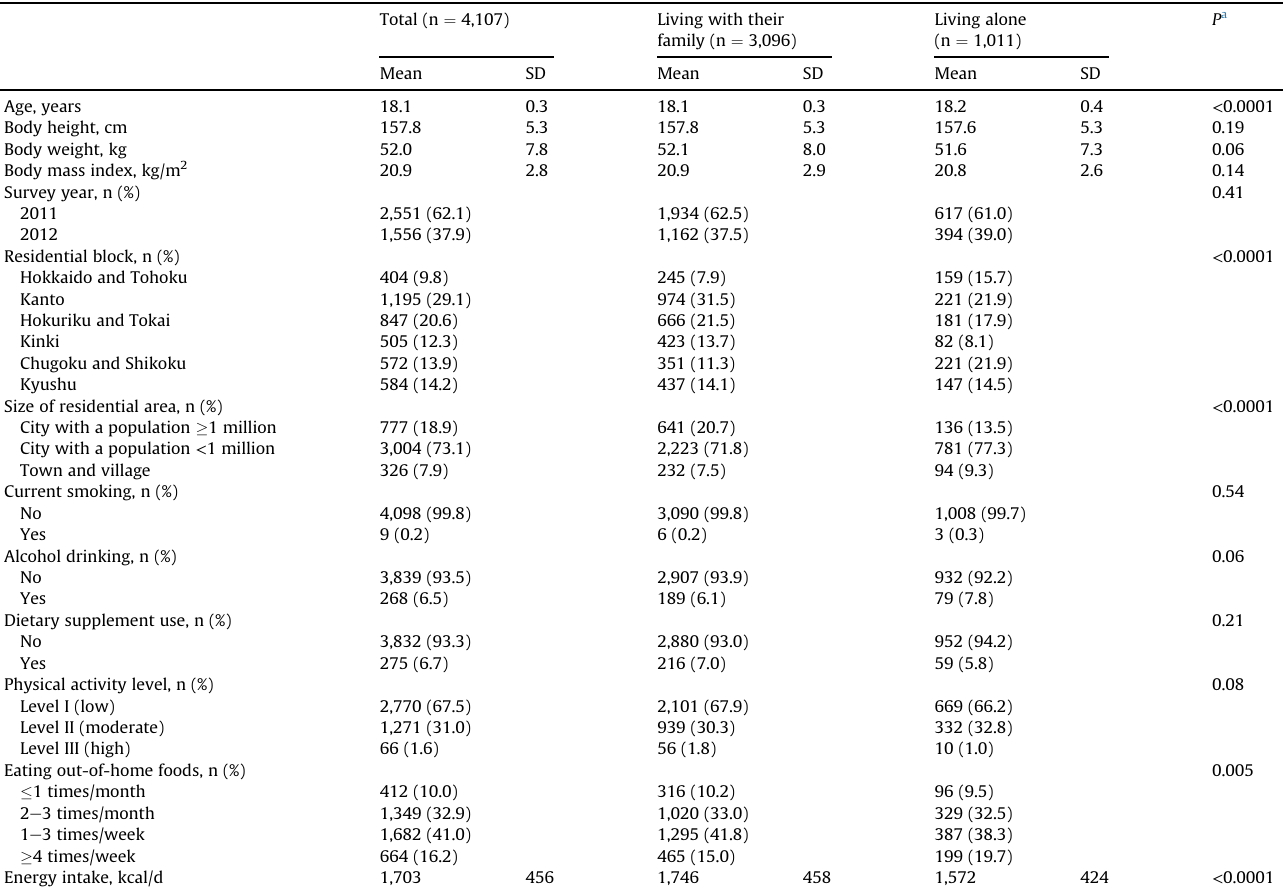
Table 1 Basic characteristics of 4,107 adult women living with their family or living